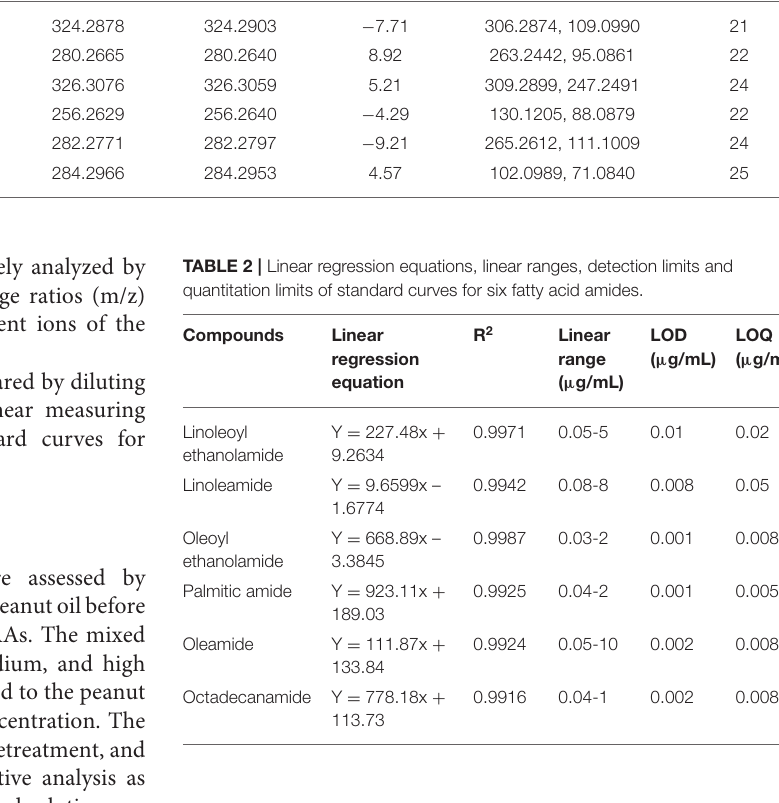
Collision energy (eV)